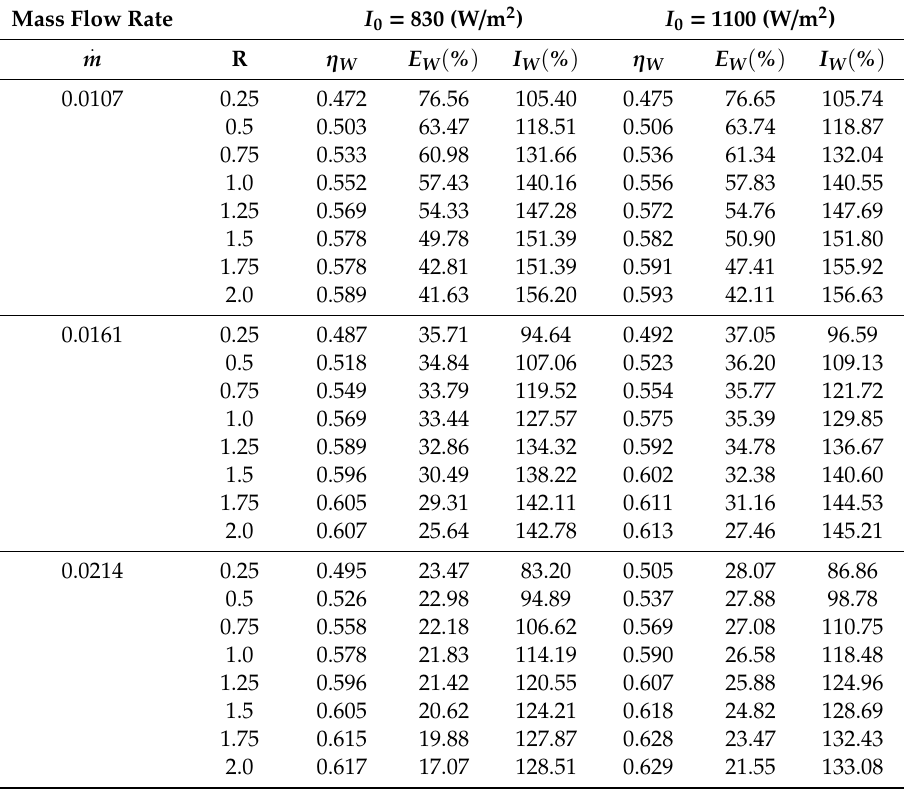
Table 1. Theoretical predictions of collector thermal e ffi ciency improvements and further